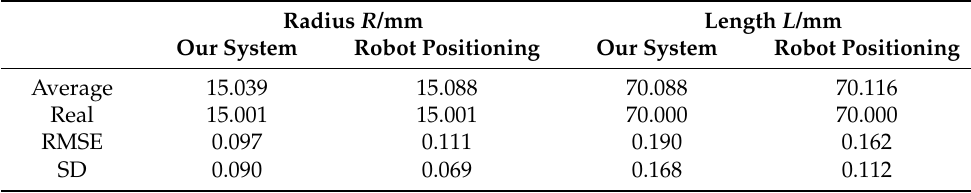
Table 7. Comparison of the measured value with the actual value.